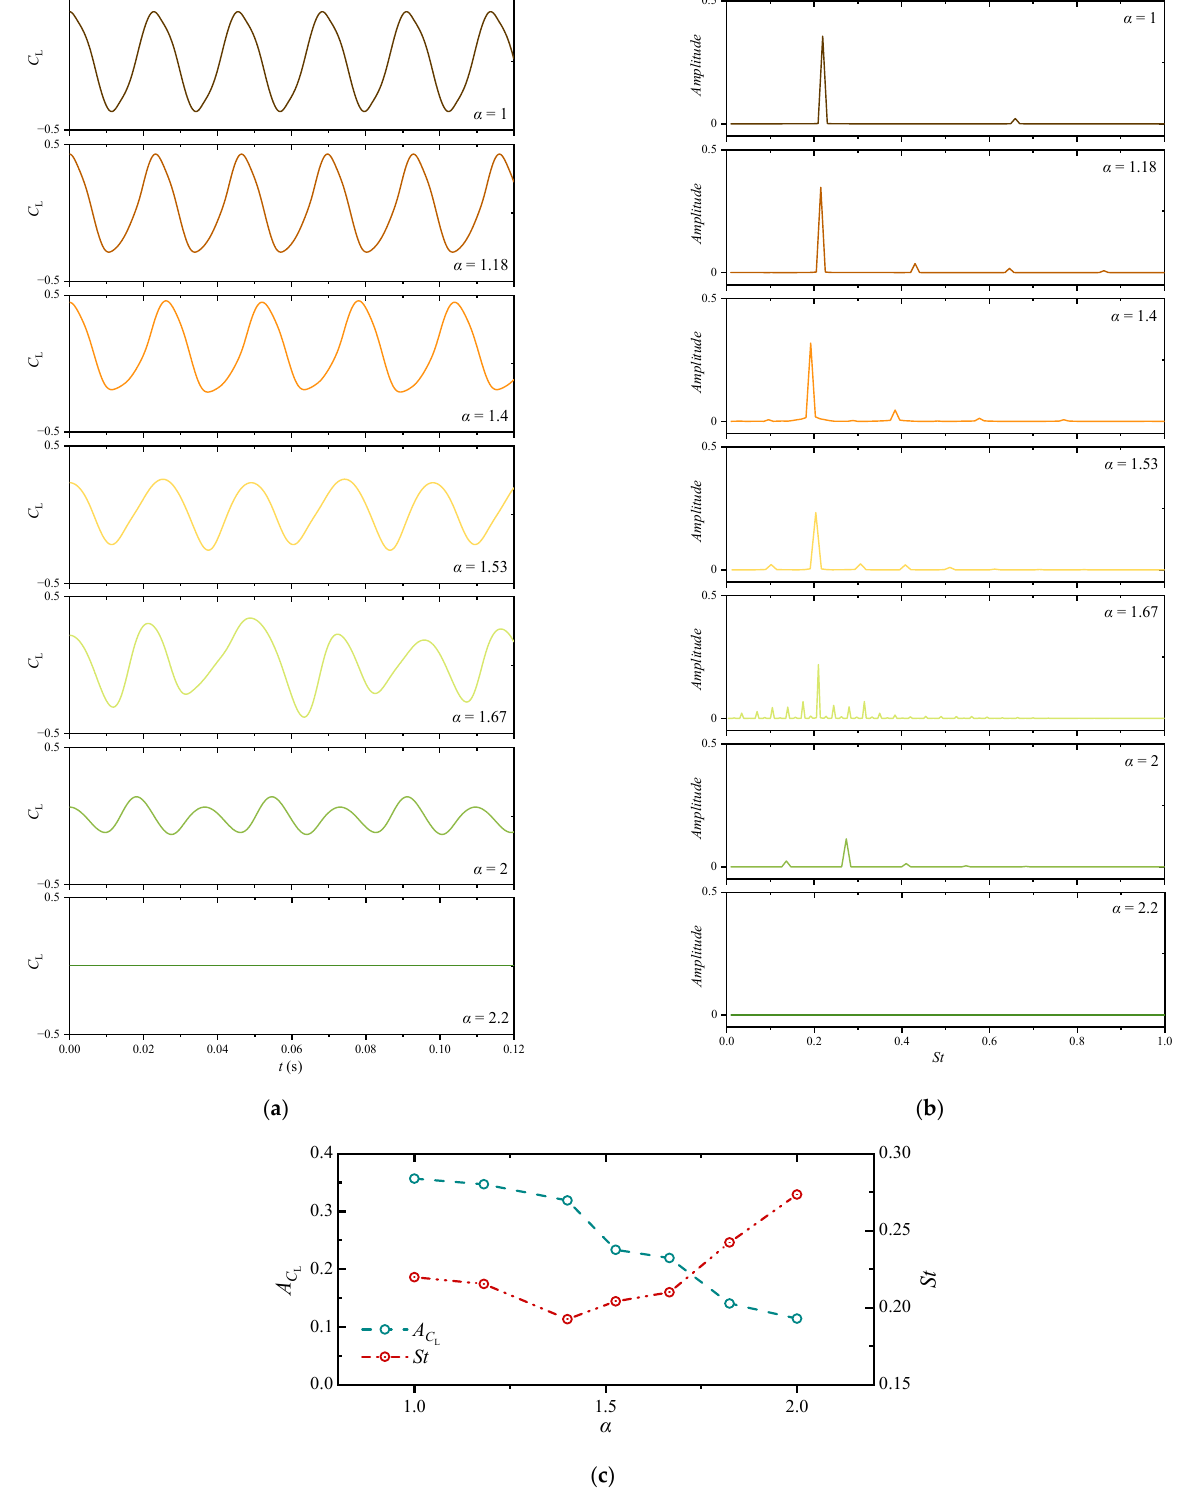
Figure 8. Lift coefficient of the hydrofoil under different α : ( a ) time domain plot, ( b ) frequency domain plot, and ( c ) values of A C L and St.